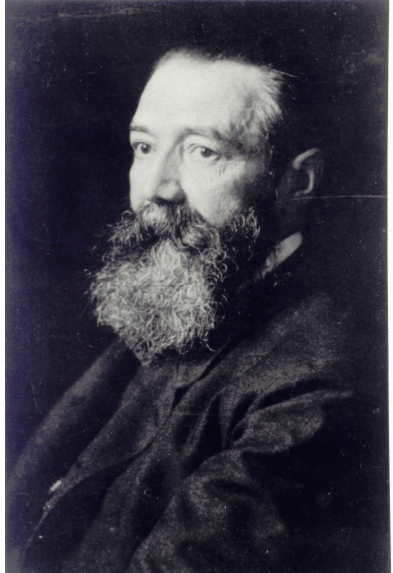
Figure 1. German neuropsychiatrist Paul Julius Möbius (1853–1907) made several contributions to endocrine processes underlying both human behavior and certain illnesses. (Reproduced with permission from: Archives for the History of Psychiatry in Leipzig).